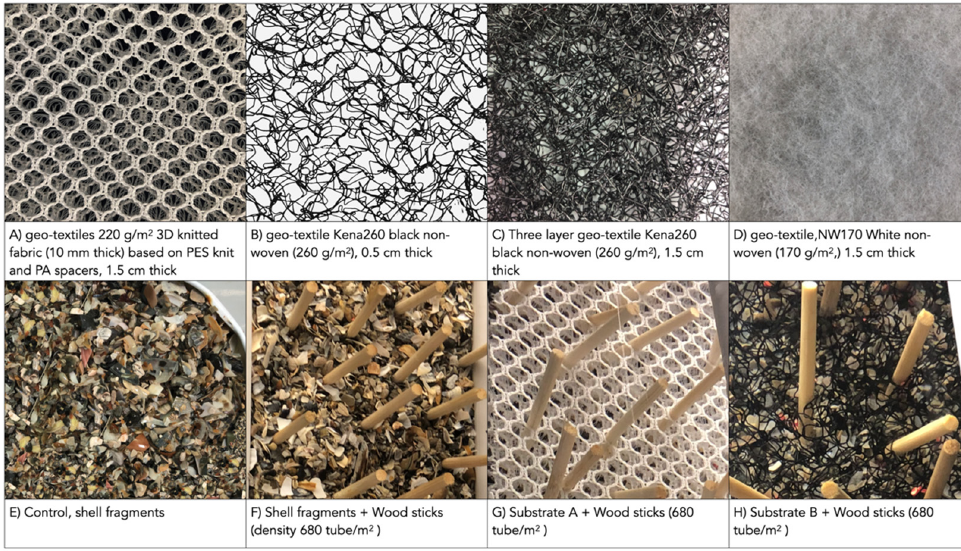
Figure 3. Pictures and descriptions of all artificial substrates tested.